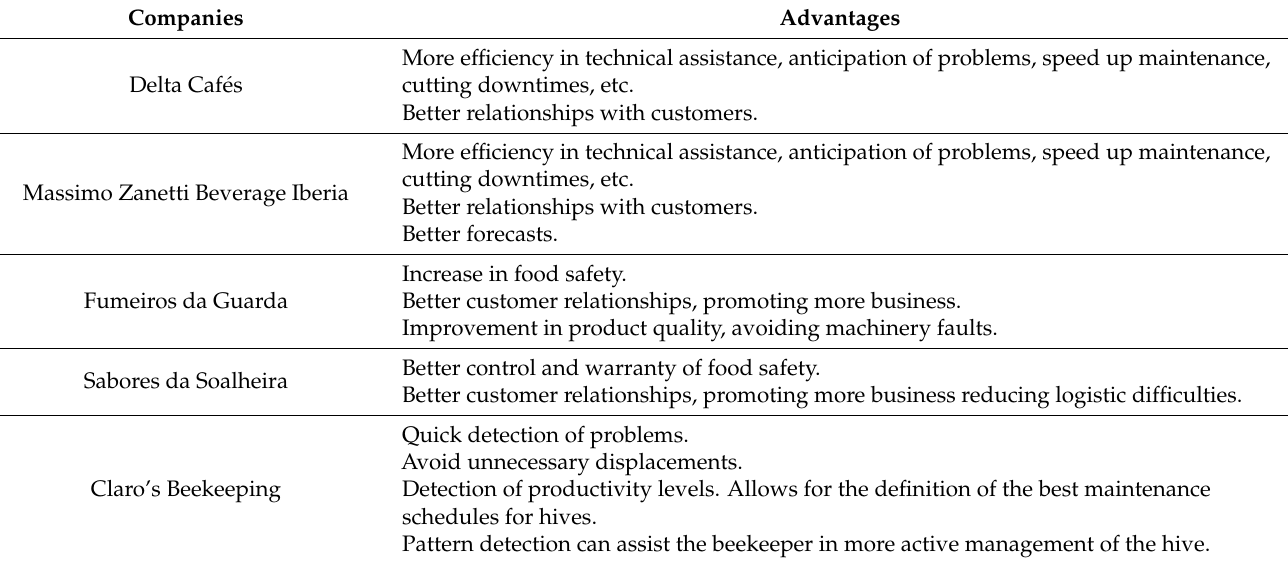
Table 7. Advantages of IoT solutions implementation according to each company.